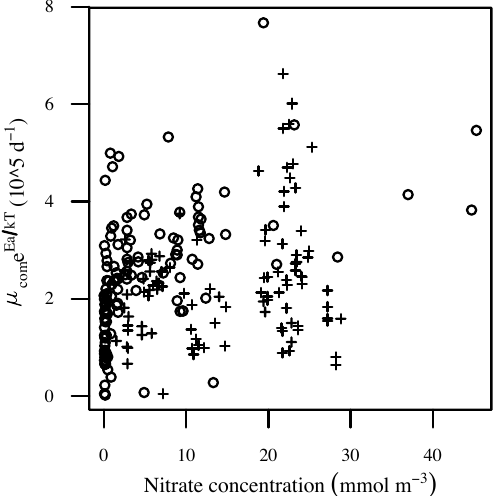
Figure 4. Relationship between in situ community growth rates ( µ com e Ea / KT , d − 1 ) corrected by temperature using the average ac- tivation energy for autotrophic respiration (Ea = − 0 . 33eV; López- Urrutia et al., 2006) and nitrate concentration (mmolm − 3 ). Crosses represent phytoplankton communities of Table A1 sampled in HNLC regions and circles represent the rest of the phytoplankton communities from the Table A1 data